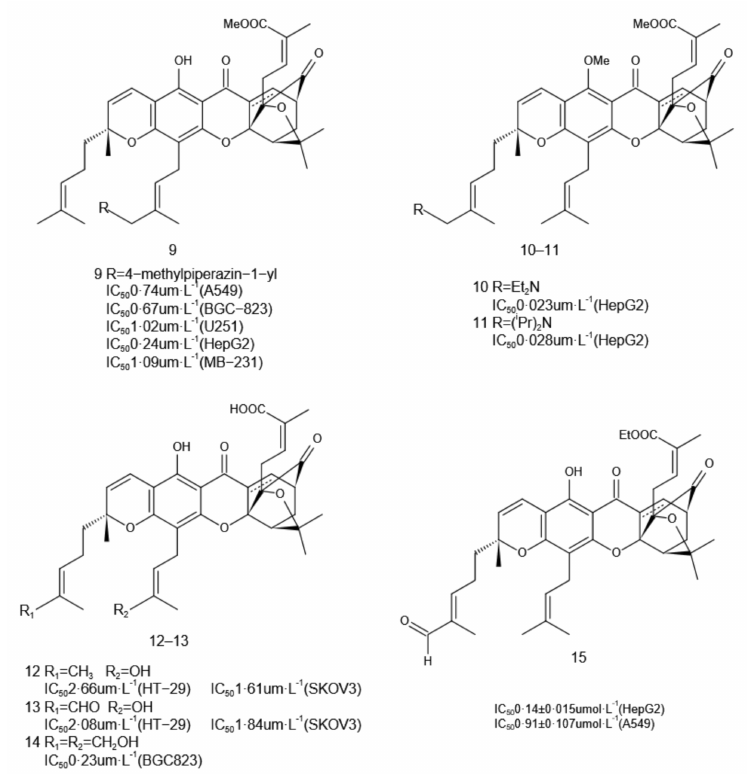
Figure 5. Structural modifications at the C-34/39 allylic